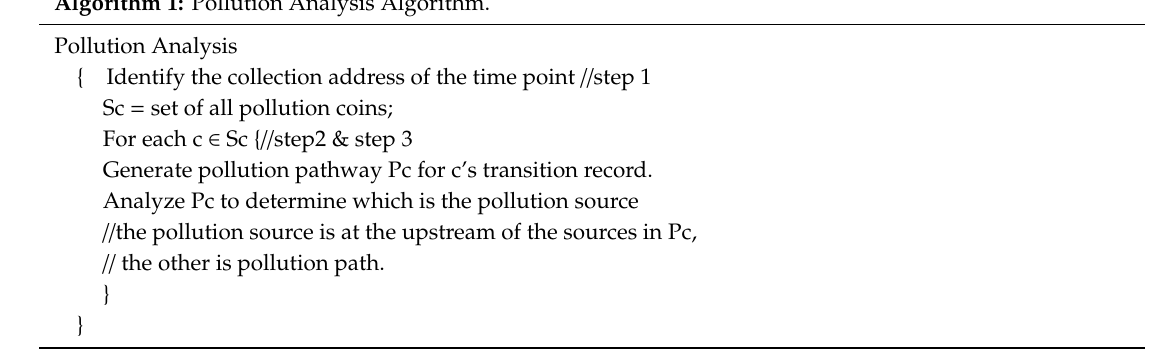
Algorithm 1: Pollution Analysis Algorithm. Pollution